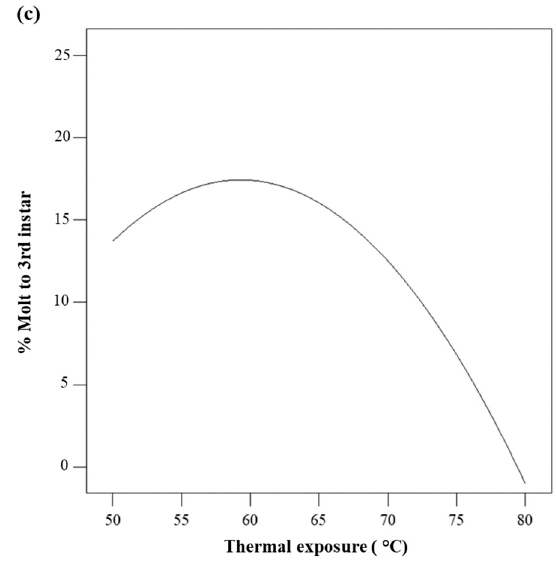
Figure 4. Nonlinear effects of mild thermal exposure (50–80 °C) for 15 min on dry weight ( a ), percent successful completion of molt to 2nd instar ( b ), and percent successful completion of molt to 3rd instar ( c ). Western corn rootworm larvae reared on WCRMO-2 diet for 10 days.